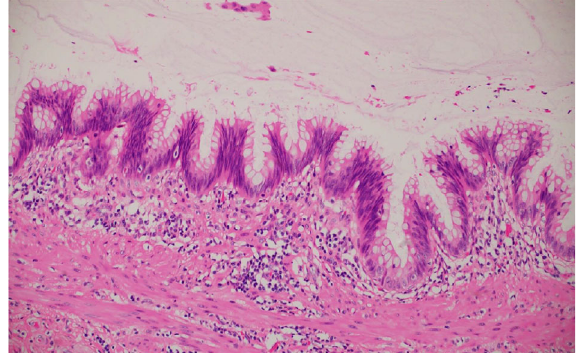
Figure 7: Dysplastic mucosa lining the lesion, H and E × 40.